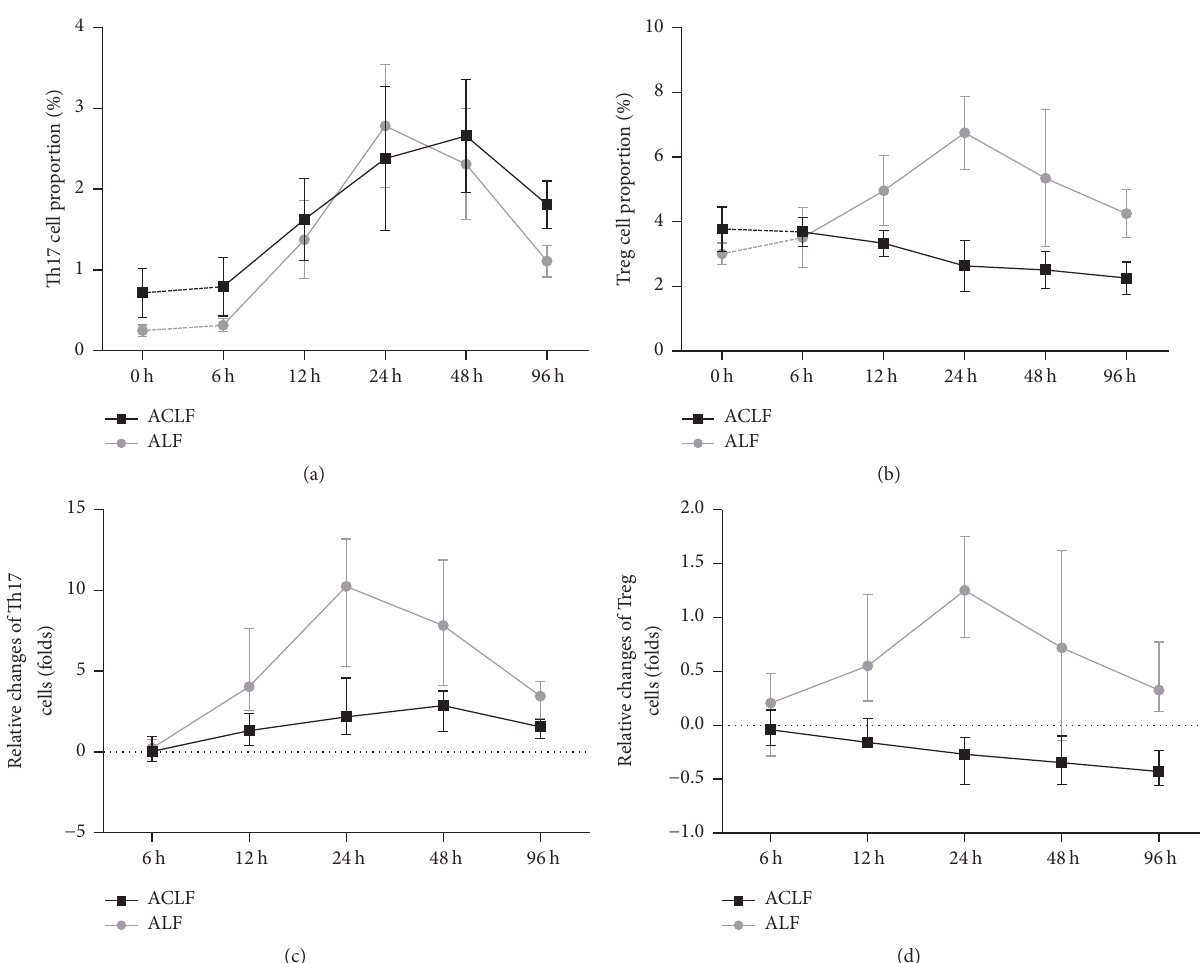
Figure 5: The changes of Th17 and Treg cell proportions. (a, b) Th17 and Treg cell proportions; results were shown as means ± SD. (c, d) Relative changes of Th17 and Treg cells.